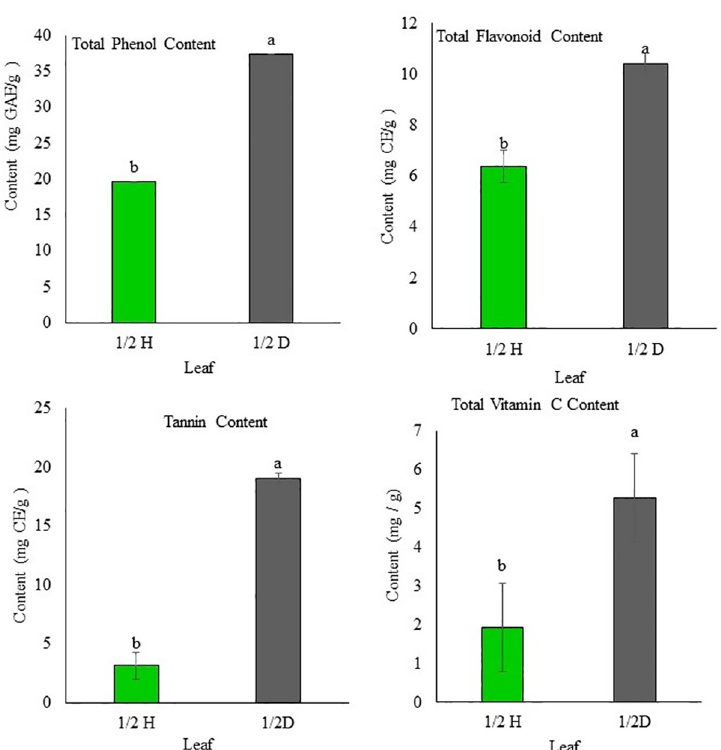
Fig 3. Phenolic compound and vitamin C content in 1/2 H: asymptomatic part of infected leaf and 1/2 D: symptomatic part of infected leaf. Different letters indicate that the means are significantly different at 95% confidence